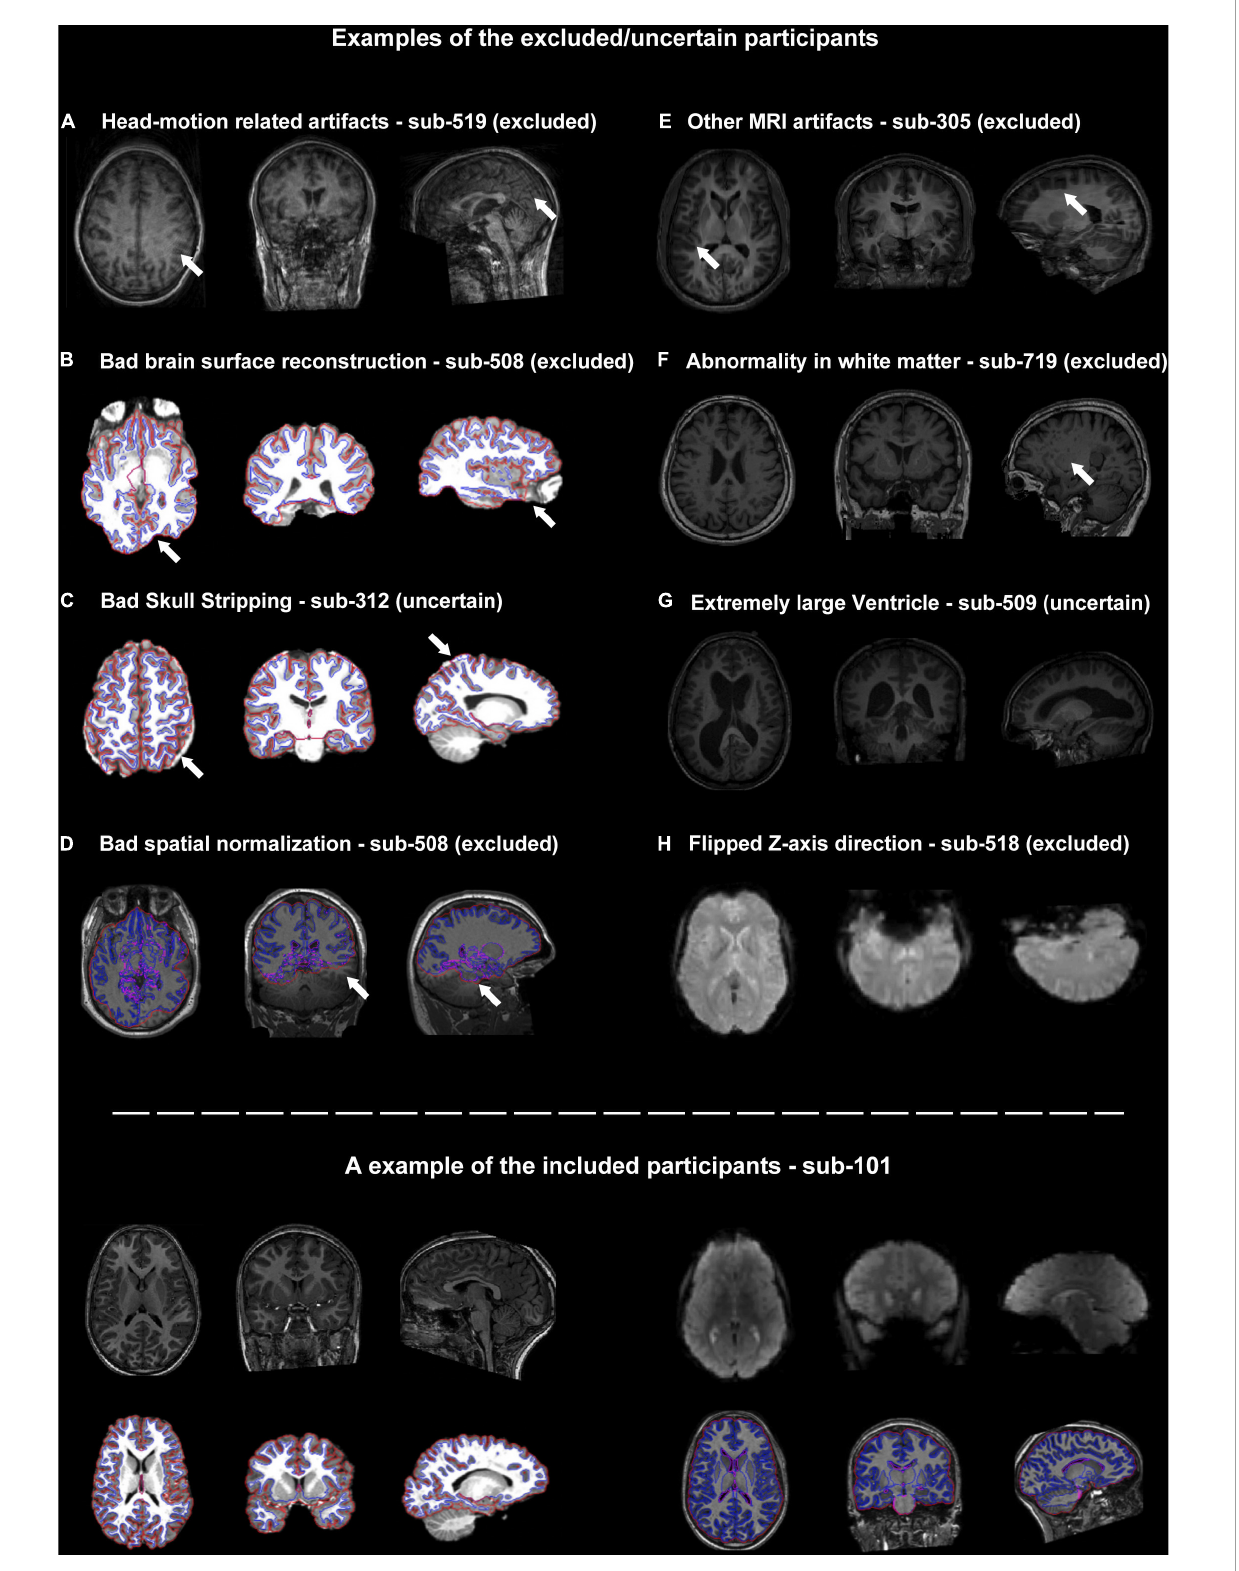
FIGURE2 Representative examples of quality control (QC) items for which subjects were categorized as excluded or uncertain. (A–H) Examples of images with inadequate quality. The suspicious areas were highlighted using white arrows. The lower panel of the graph showed an example of the included